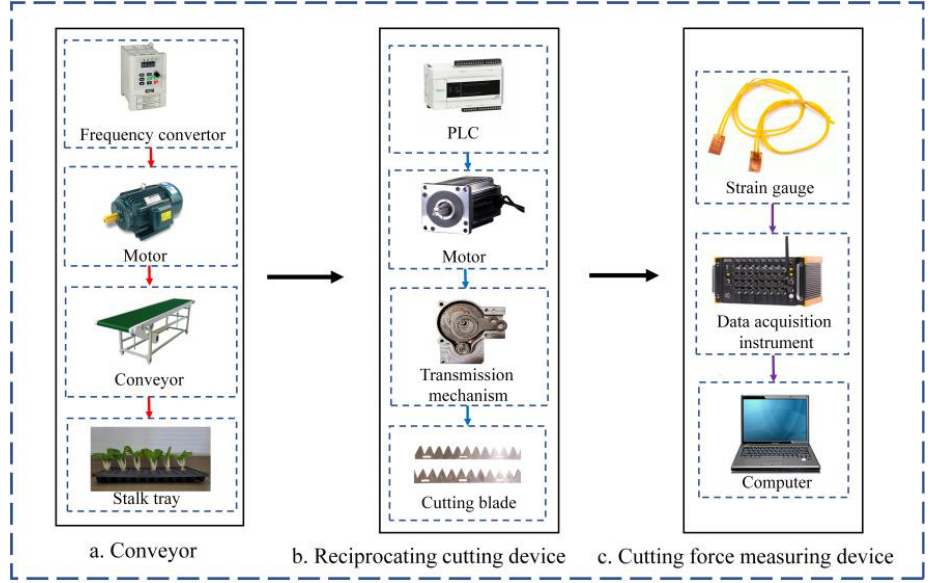
Figure 6. Structural diagram of the cutting force measurement system.